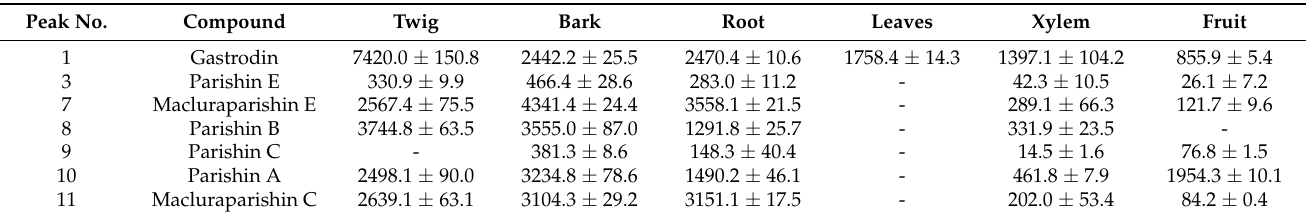
Table 3. Comparative analysis of parishin-related compounds from different parts of